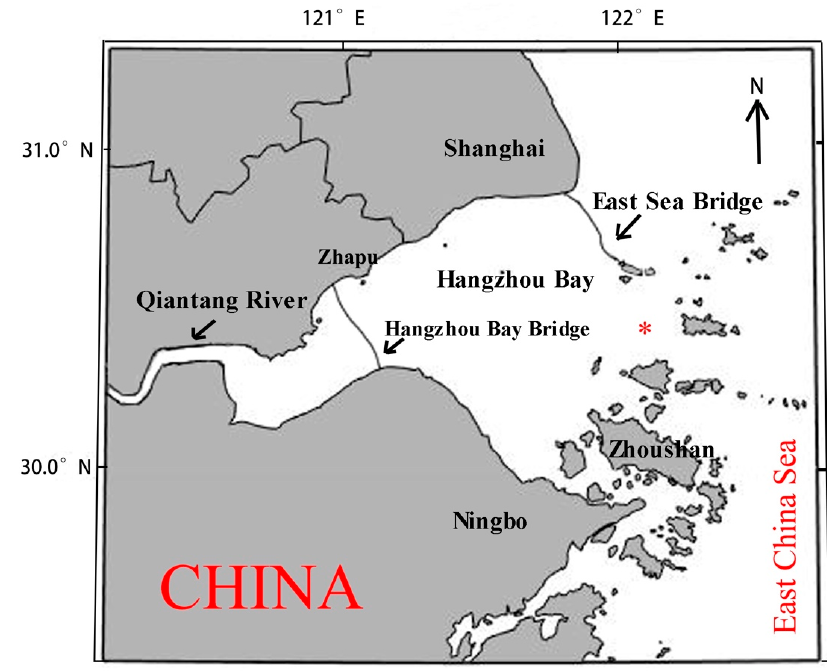
Figure 1. The map of the Hangzhou Bay and the location of Hangzhou Bay Bridge (HBB). The red star is the measuring point.